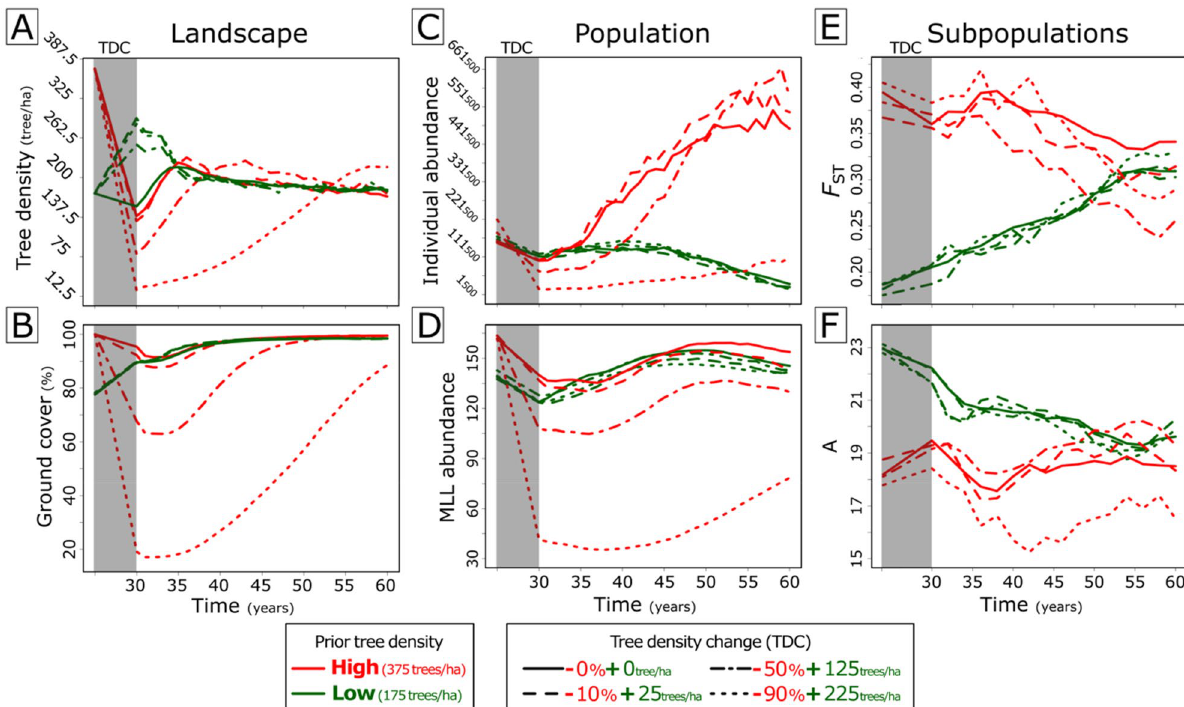
Figure 5. Temporal patterns obtained from multiple simulations of the spreading of Tillandsia recurvata populations in dynamic landscapes (emulating tree growth, regeneration, and self-thinning of natural forests) with prior high and low tree densities after abrupt reductions (lines in red) or increments (lines in green) in tree densities (shaded areas). The first 30 simulated years, not shown here, correspond to the simulations in static landscapes presenting the lowest and highest F ST (considering high tree density conditions) showed in Fig. 4C,D. From the first to the last column, the figures show 30-years of posterior temporal variation in landscapes’ tree density ( A ) and ground cover (i.e. the relative number of simulated landscape patches not covered by tree trunks or crowns; ( B ); in the T. recurvata ’s population abundance of individuals ( C ) and multi-locus lineages (MLLs; ( D ); and in subpopulation’ differentiation ( F ST ; E ) and the average number of alleles ( A ; F ). Lines represent the averages of each represented variable in 2000 simulations. Solid, dashed, dotted-dashed, and dotted lines represent, respectively, absent, low, intermediate, and high anthropogenic changes in tree density